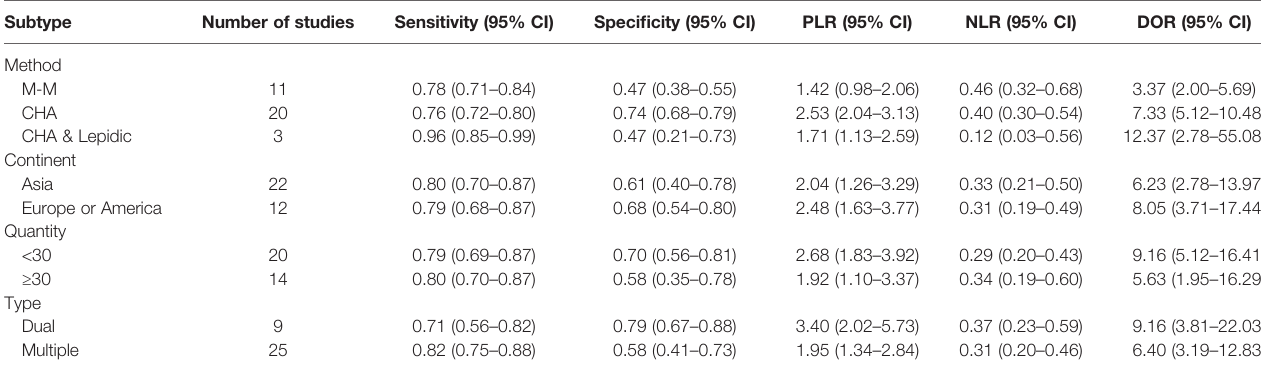
TABLE 3 | Summary results of the subgroup analysis for histology in the differential diagnosis of MPLC and